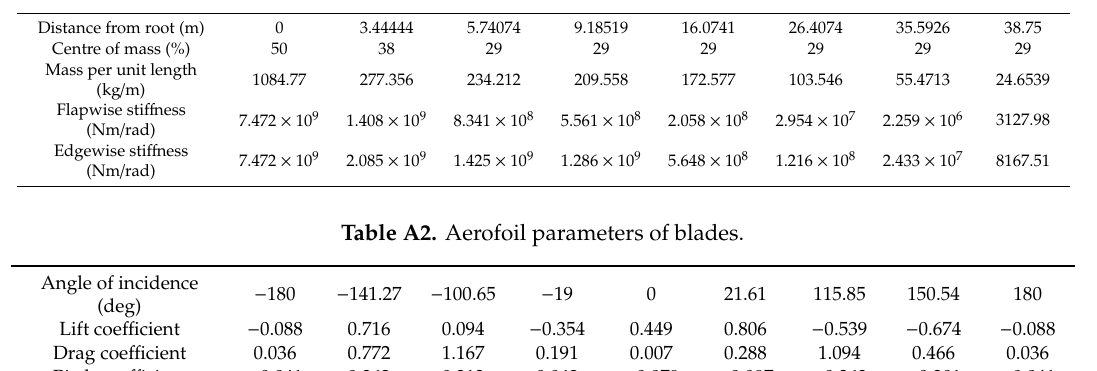
Table A1. Design parameters of blades.